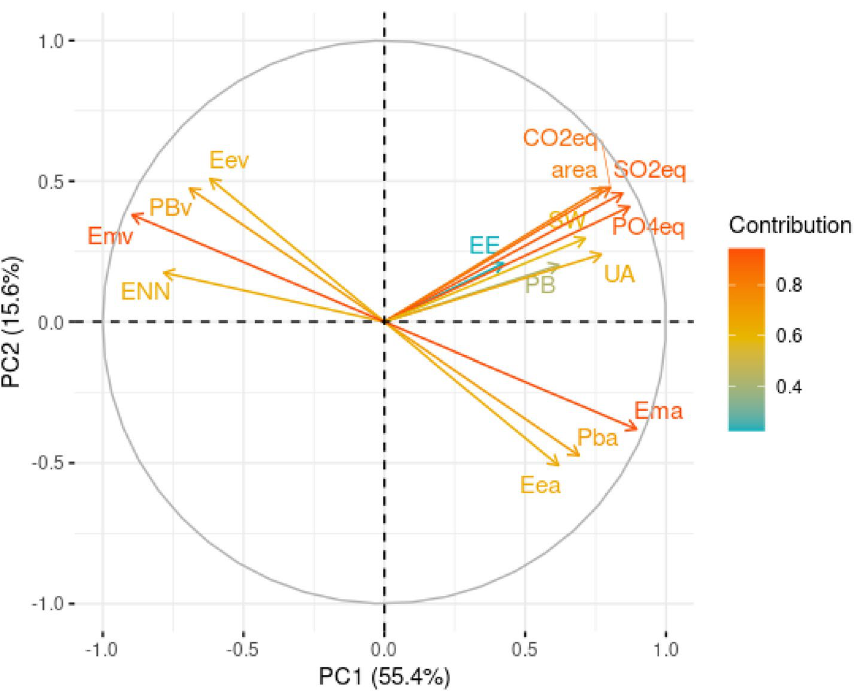
Figure 6. Principal component analysis (PCA) of first principal component (PC1) versus second principal component (PC2) of diets for cats. ENN nitrogen-free extract, PBv protein from vegetable origin, Emv metabolizable energy from vegetable origin, Eev fat from vegetable origin, CO2eq carbon dioxide equivalent, area land use, PO4eq phosphate equivalent, SW stress-weighted water usage, SO2eq sulphur oxide equivalent, UA freshwater withdrawals, PB protein content, EE fat content, Ema metabolizable energy from animal sources, Pba protein from animal sources, Eea fat from animal